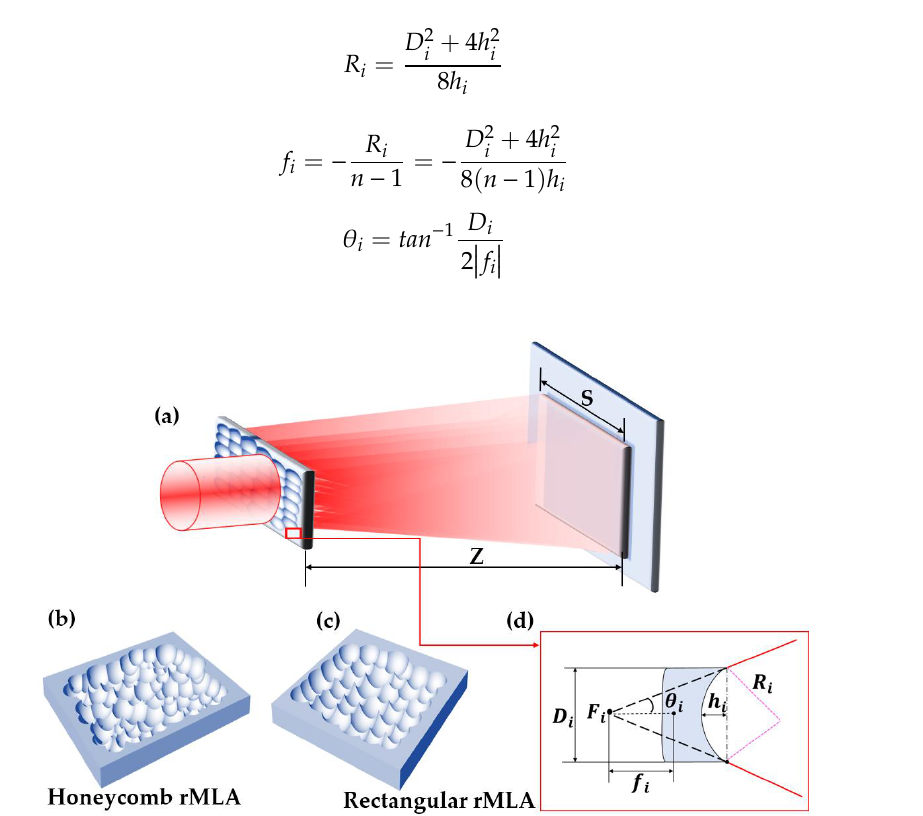
Figure 1. ( a ) Schematic diagram of random microlens array (rMLA); ( b ) structural parameters of microlens unit; ( c ) honeycomb rMLA; ( d ) rectangular rMLA.